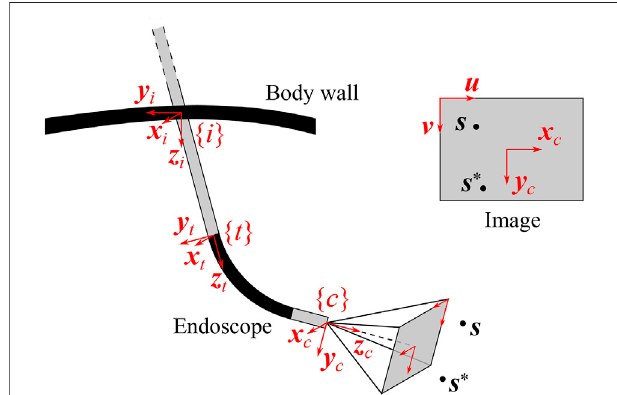
FIGURE 8 | De fi nition of reference frames in a generalized endoscope model.Theincisionframe{ i }islocatedattheincisionpointinthebodywall,the distal tip frame { t } at the end of the straight endoscope shaft and the camera frame { c } at the end of the endoscope, in the optical center of the camera. The image produced by the endoscope is also shown (upper right insert), along with the projections of the detected feature of interest s and its desired position s *, and with the image coordinate vectors ( u , v